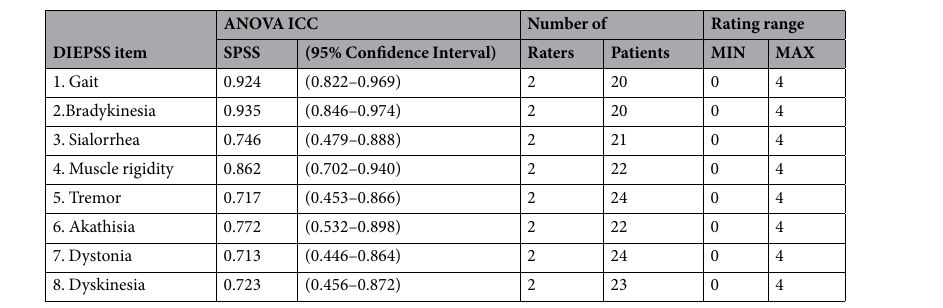
Table 2. Test-retest reliability of DIEPSS Serbian